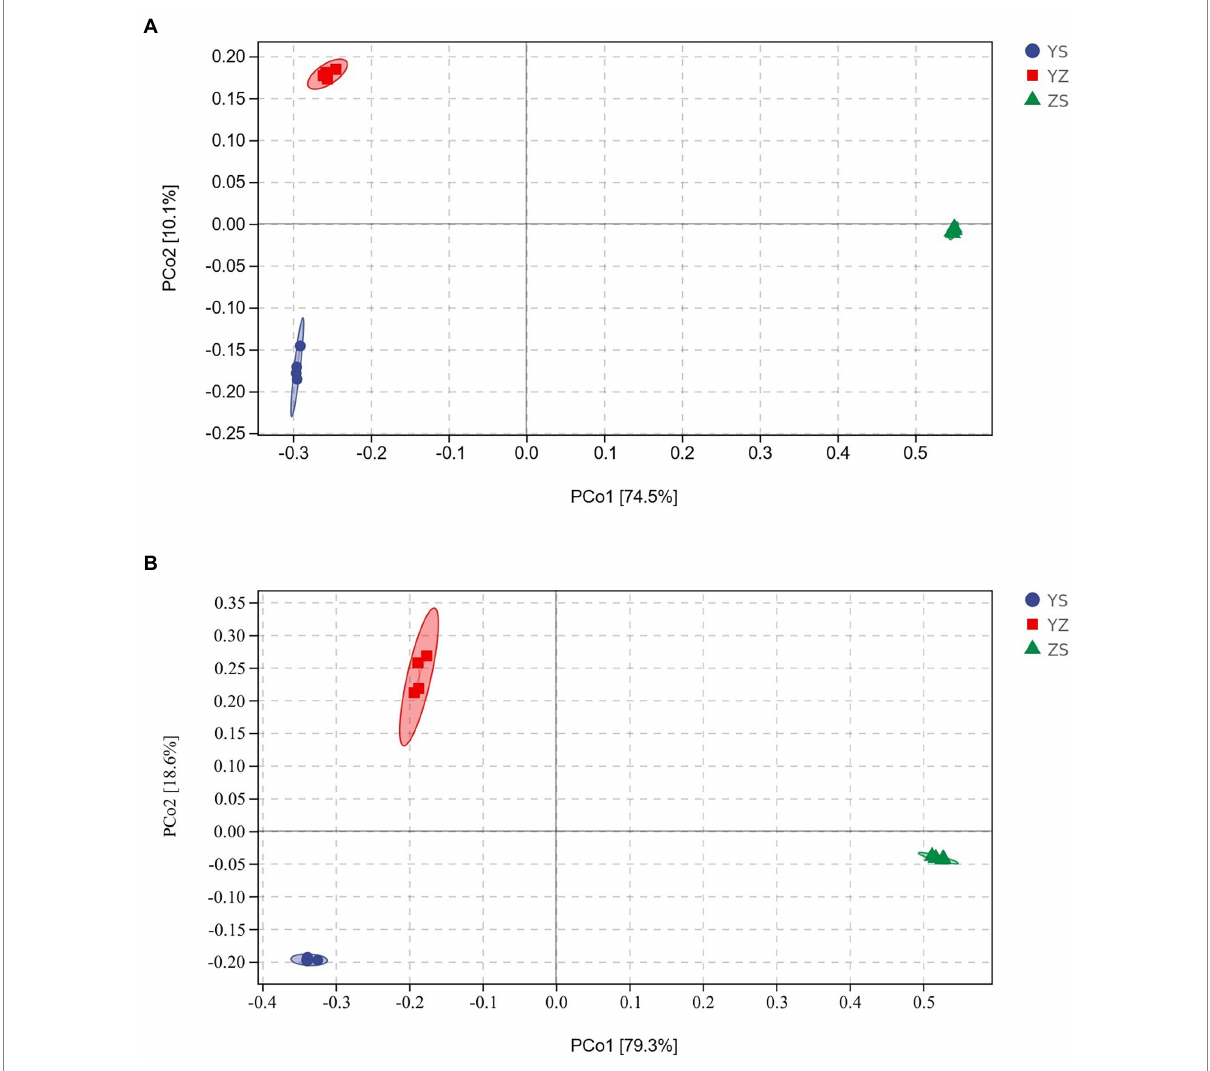
FIGURE 2 Priniciple coordinate analysis (PCoA) of Bray-Curtis’ diatance from all samples. (A) PCoA of bacteria communities in different samples; (B) PCoA of fungal communities in different samples. YS: Populus × canadensis Moench; YZ: Populus × canadensis Moench- Pinus sylvestris var. mongolica ; ZS: Pinus sylvestris var. mongolica